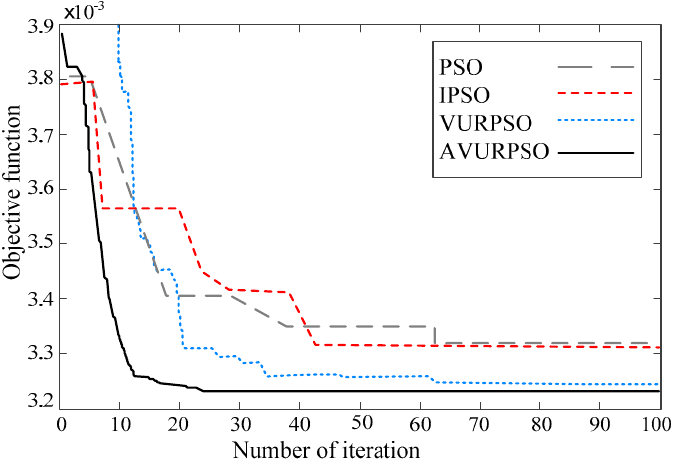
Figure 4. Convergence speeds of PSO and AVURPSO algorithms.